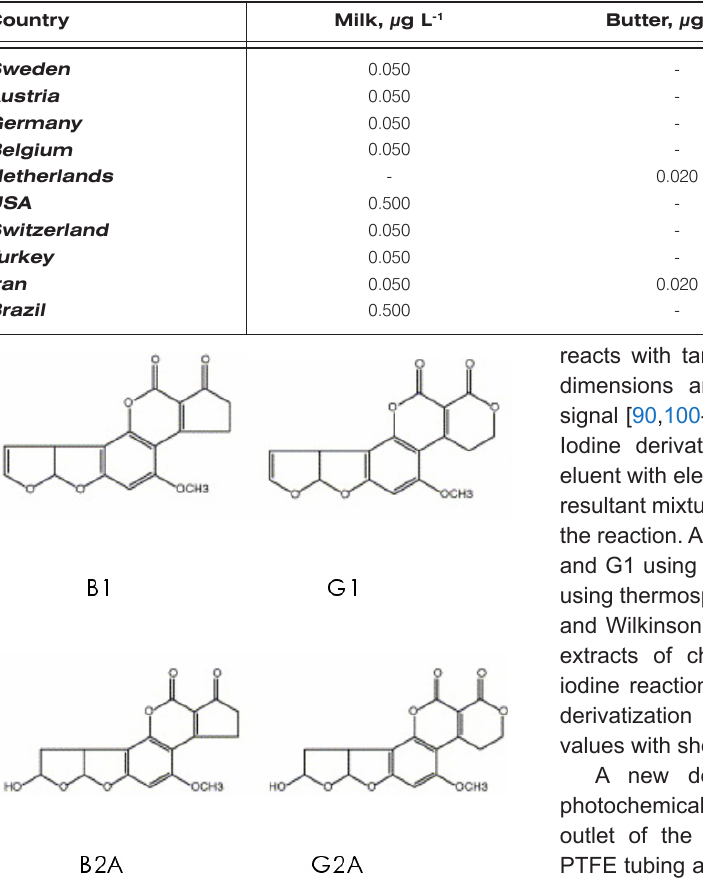
Figure 1. Structures of B1, G1, B2A and